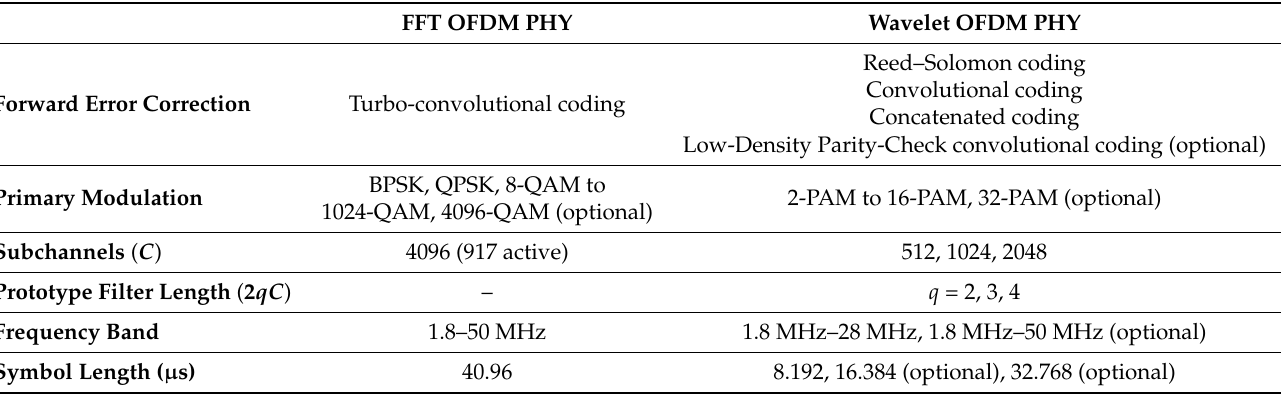
Table A1. IEEE BB-PLC Standard 1901 FFT OFDM and wavelet OFDM PHYs major specifications. FFT OFDM PHY